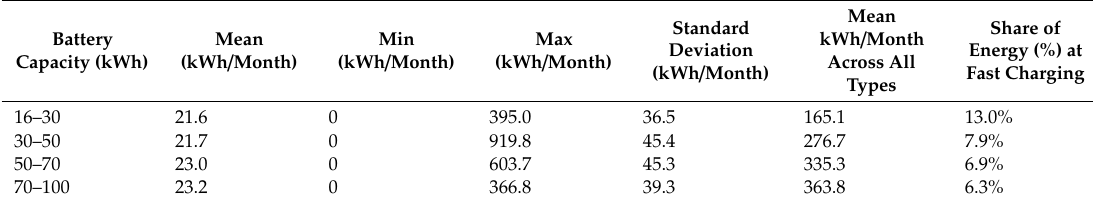
Table 3. Descriptive statistics of energy charged per month at fast charging stations per range of battery capacity.